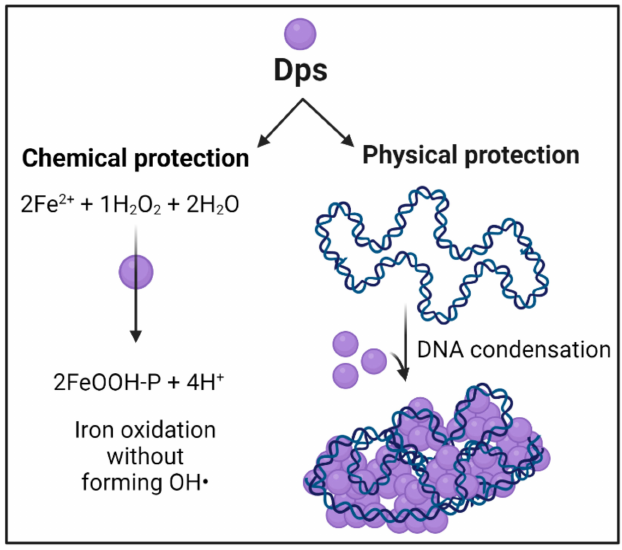
Figure 2. Dps protects DNA via chemical and physical